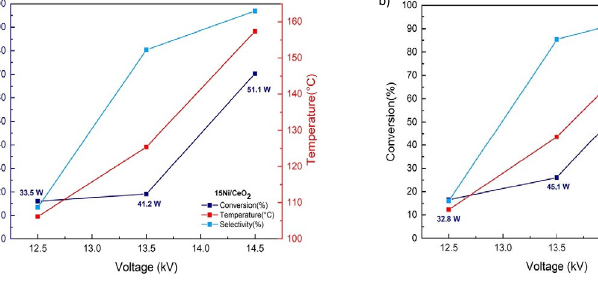
Furthermore, for all the range of studied voltage from 25 to 29 kV peak to peak which corresponds to 12.5kV to 14.5kV peak voltage in Figure 9, the 1Co15Ni/CeO 2 catalyst ex-